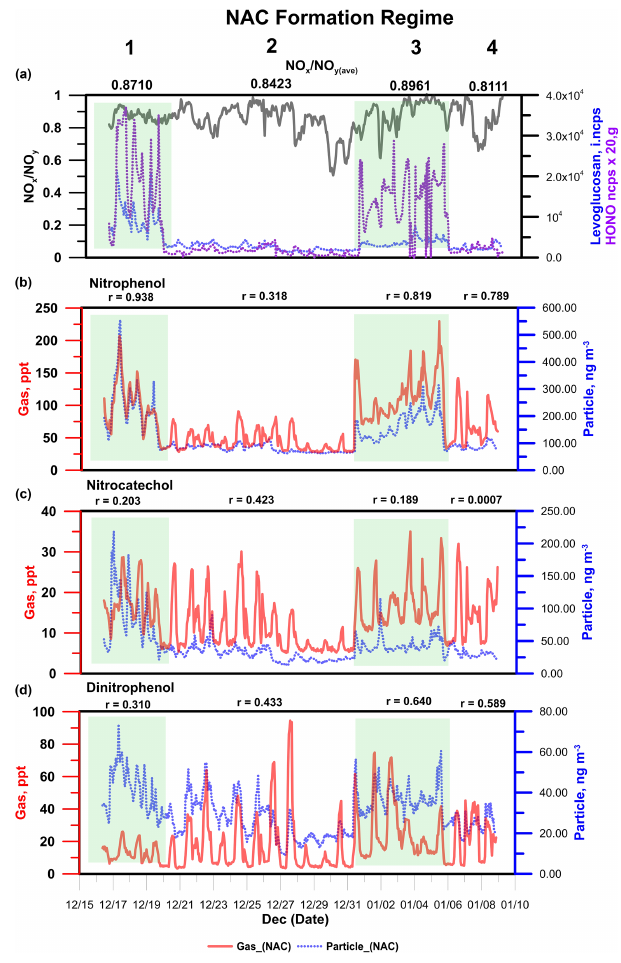
Figure 4. (a) Time series of particle-phase concentrations of lev- oglucosan, gas-phase concentrations of HONO, and ratios of NO x to NO y as markers of BB episodes during field measurements. (b, c, d) Mixing ratios of nitrophenol, nitrocatechol, and dinitrophenol under regimes corresponding to BB episodes and non-BB episodes. The coefficient of correlation ( r ) reflects the agreement between the gas- and particle-phase